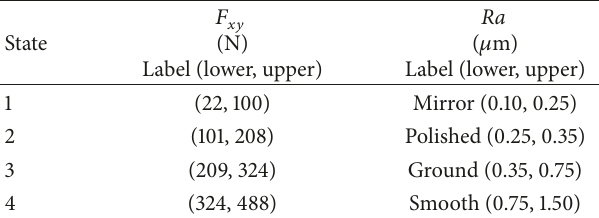
Table 2: Variables and intervals